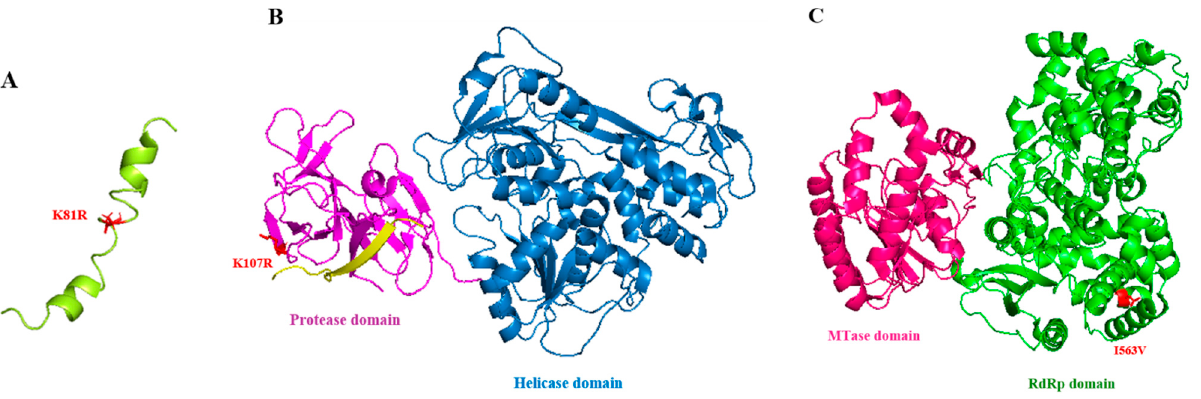
Figure 2. The crystal structure of DENV NS2A, NS3, and NS5 proteins. ( A ) Ribbon representation of the protein structure of NS2A (first transmembrane segment, PDB 2M0S). ( B ) Ribbon representation of complete NS3 (PDB 2VBC) protein structure. A small yellow beta sheet represents the NS2B cofactor, purple represents the NS3 protease domain, and a large blue molecule represents the helicase domain of the NS3 protein. ( C ) Ribbon representation of the complete NS5 (PDB 4V0Q) protein structure: pink represents the MTase domain and green represents the RdRp domain. The locations of substitutions and residues on each protein are denoted in red. Structure figures were prepared using PyMOL.